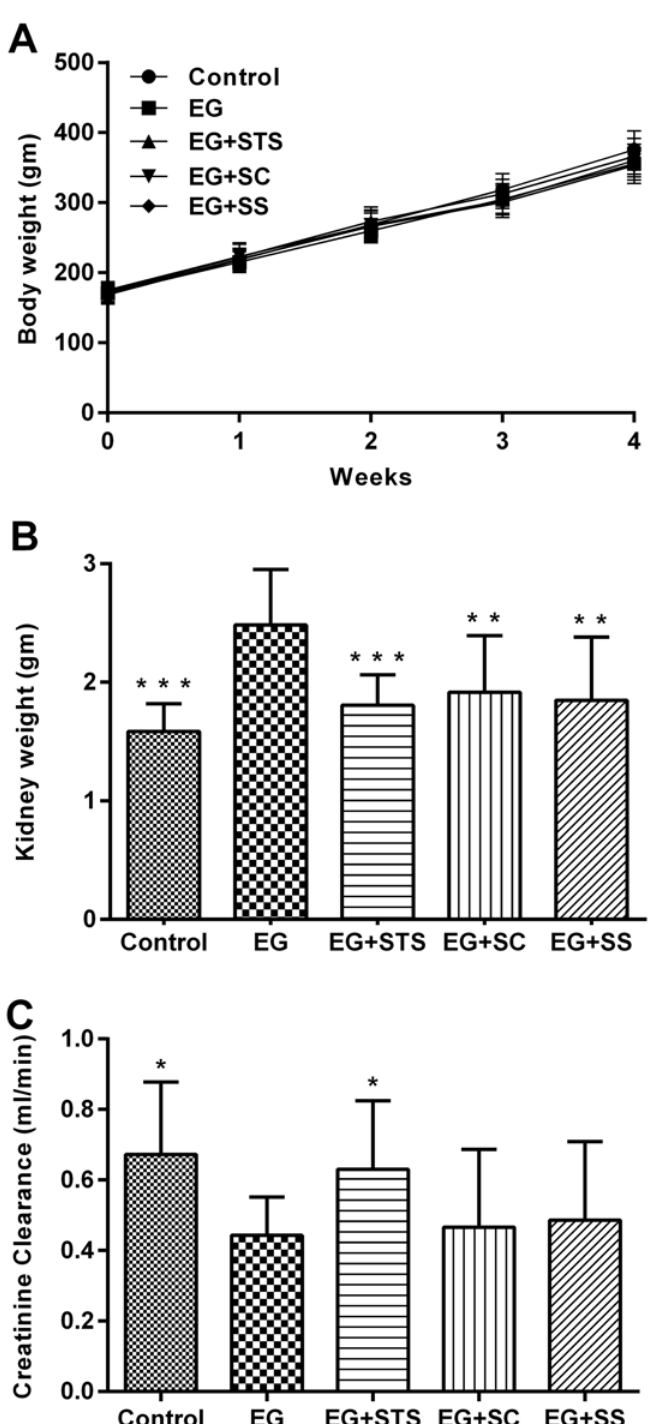
Fig 1. Treatment effects on body weight, kidney weight and renal function. (A) Initial body weight and weight gain were similar in all animal groups irrespective of the treatment modality. (B) Kidney weight was increased in the EG group, but near-to-normal in the EG+STS, EG+SC and EG+SS groups. (C) Creatinine clearance derived from 24-hour urine samples collected after 4 weeks shows preserved renal function in STS-treated animals. The significance levels are with reference to the EG group. Data are presented as means ± SD from 7 – 8 animals per group * p < 0.05, ** p < 0.01, *** p < 0.001.